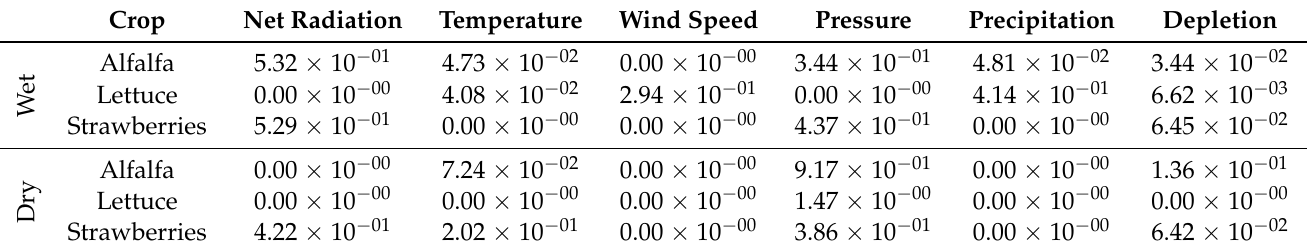
Table 3. Main effects for each crop in both wet years and dry years. MaxIPerDay = 0.0075.